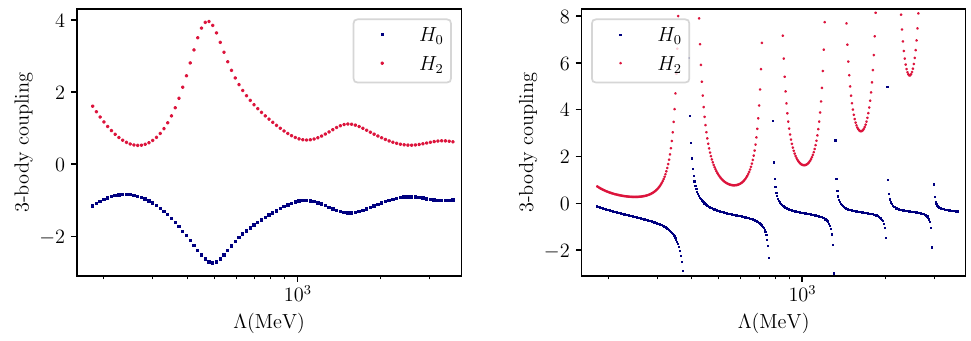
Figure 3 . The running three-body coupling constants H 0 and H 2 as a function of the cutoff Λ : p -scheme (left panel) and E -scheme (right panel). The scheme dependence of the coupling constants is evident.